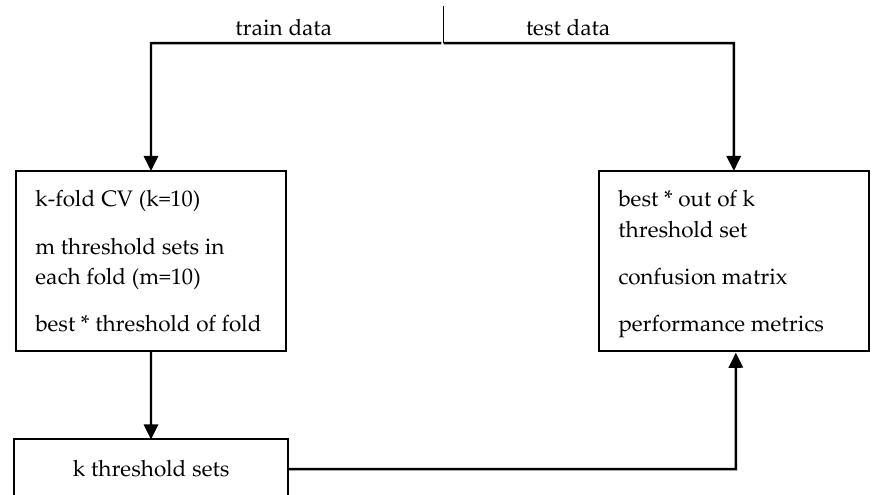
Figure 4. Block diagram of threshold selection procedure. (*) The best thresholds are the ones that yield a performance close to (0, 1) in the ROC curve.